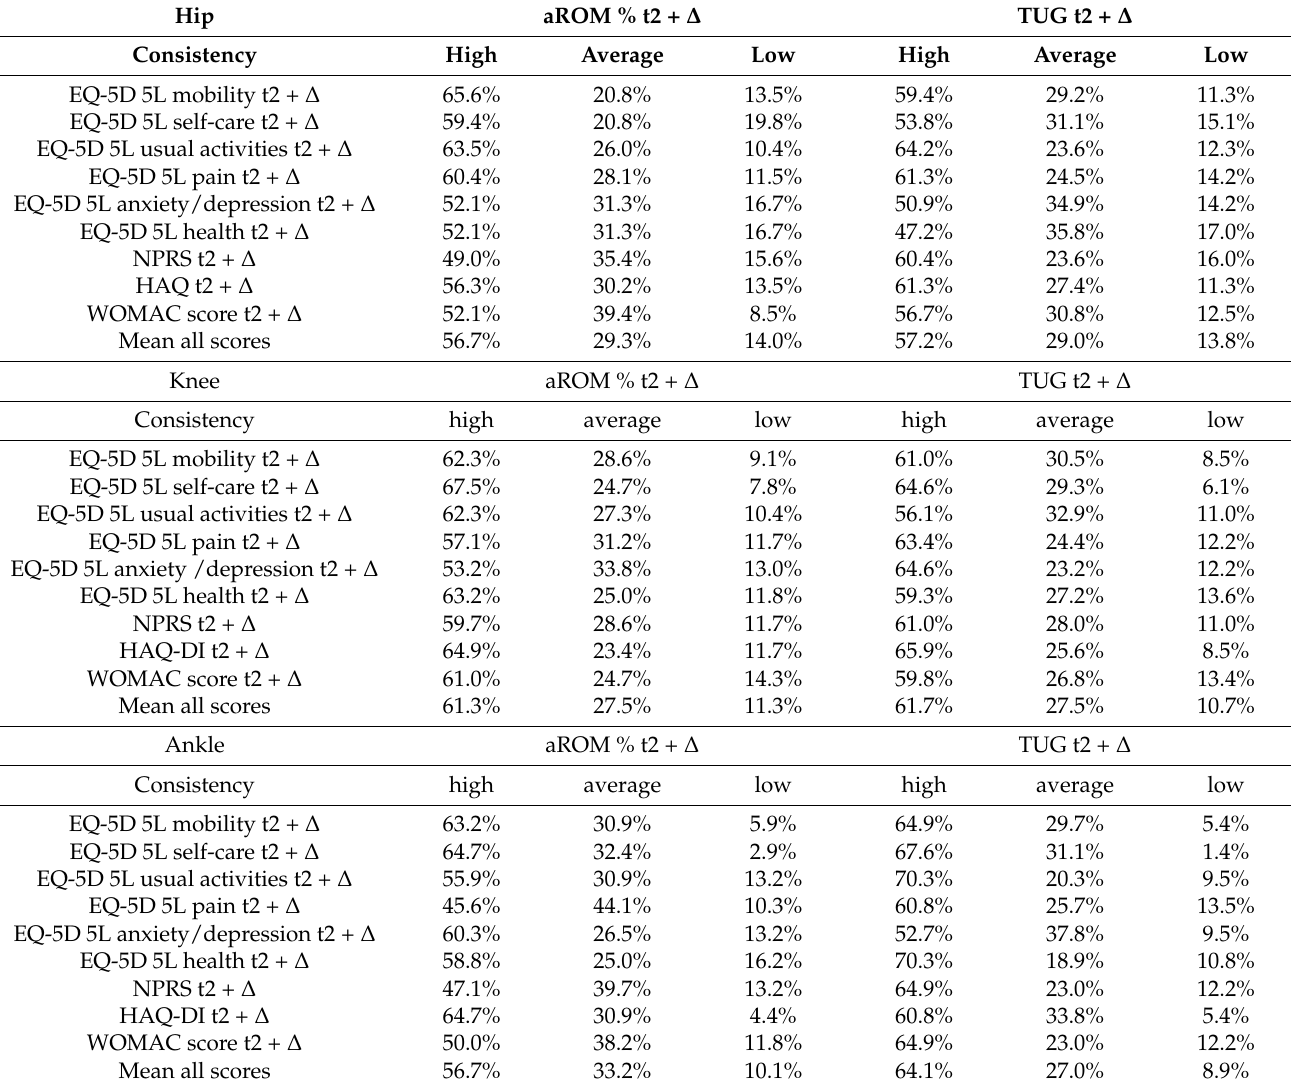
Table 4. Consistency of performance between PROMs and CROMs for all three